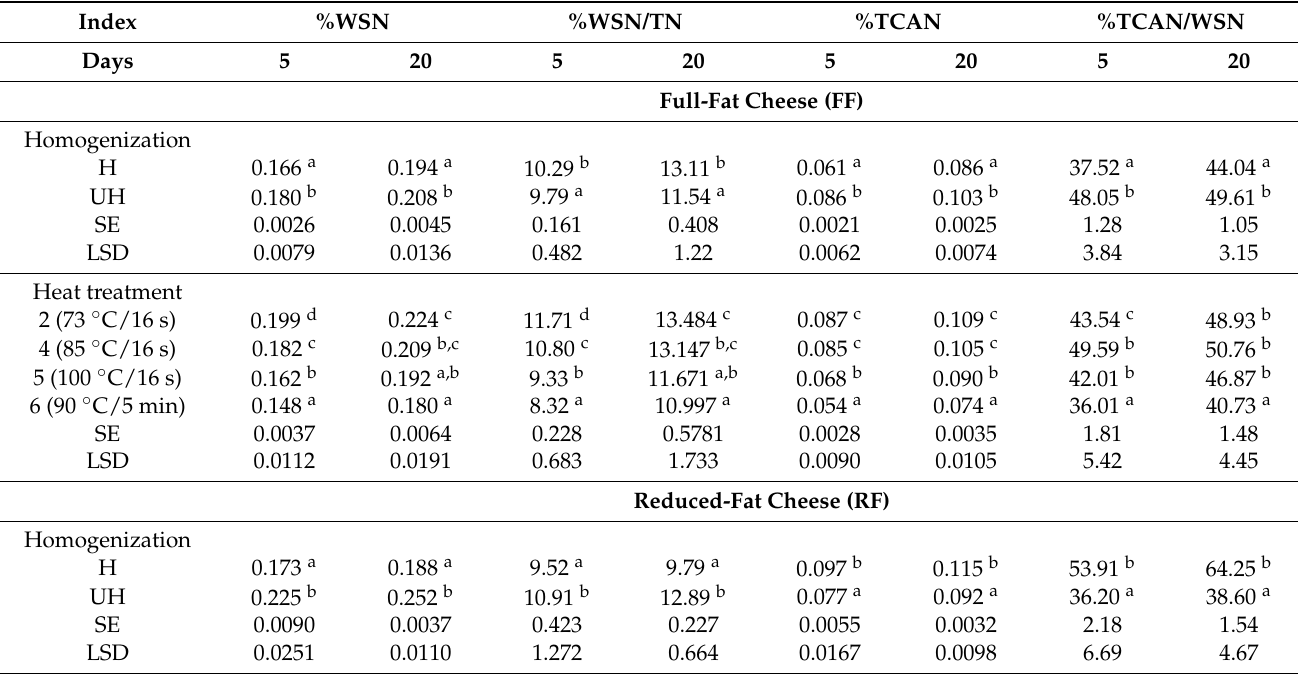
Table 5. Means of proteolysis indices of Quark-type cheeses made from unhomogenized and homogenized full- and reduced-fat milk heated under different